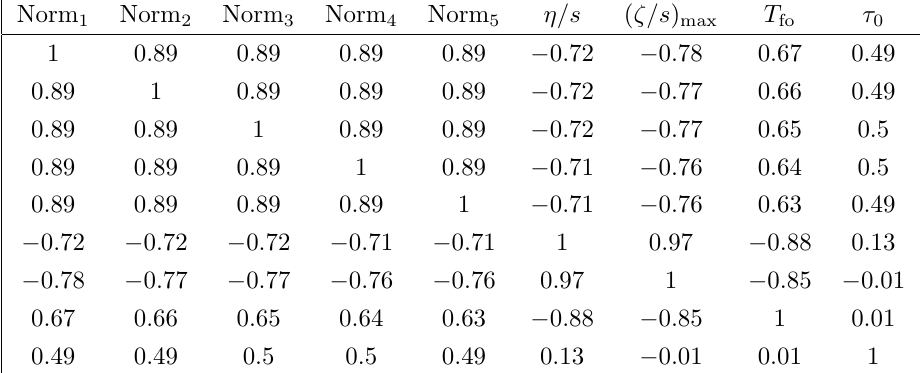
Table 2 . Correlation matrix (cid:26) ij between the (cid:12)tted parameters in a Gaussian approximation to the posterior distribution as de(cid:12)ned in eq.